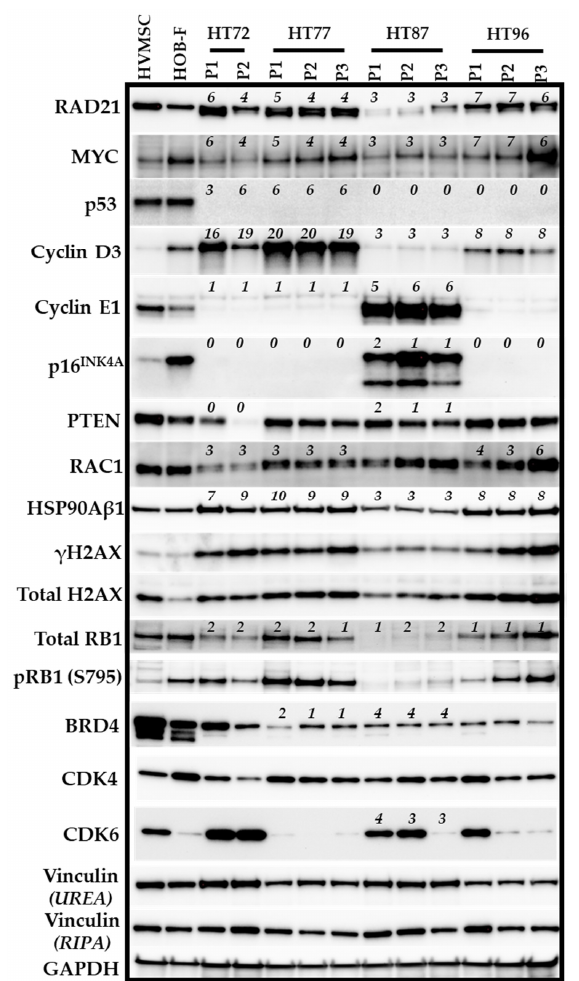
Figure 4. Impact of CNVs in oncogenic-associated genes on corresponding protein levels. CNV- protein links were evaluated by Western blots on tumor lysates from passages (P1, P2, and P3) of the OS PDXs (HT72, HT77, HT87, and HT96). Baseline levels of selected proteins of interest were: RAD21, MYC (c-MYC), p53, Cyclin D3, Cyclin E1, p16 INK4A , PTEN, RAC1, HSP90Aβ1, γH2AX, total H2AX, p-RB1 (S795), total RB1, BRD4, CDK4, and CDK6. Vinculin served as the loading control and was probed from lysates extracted in urea or RIPA buffers since proteins of interest were efficiently